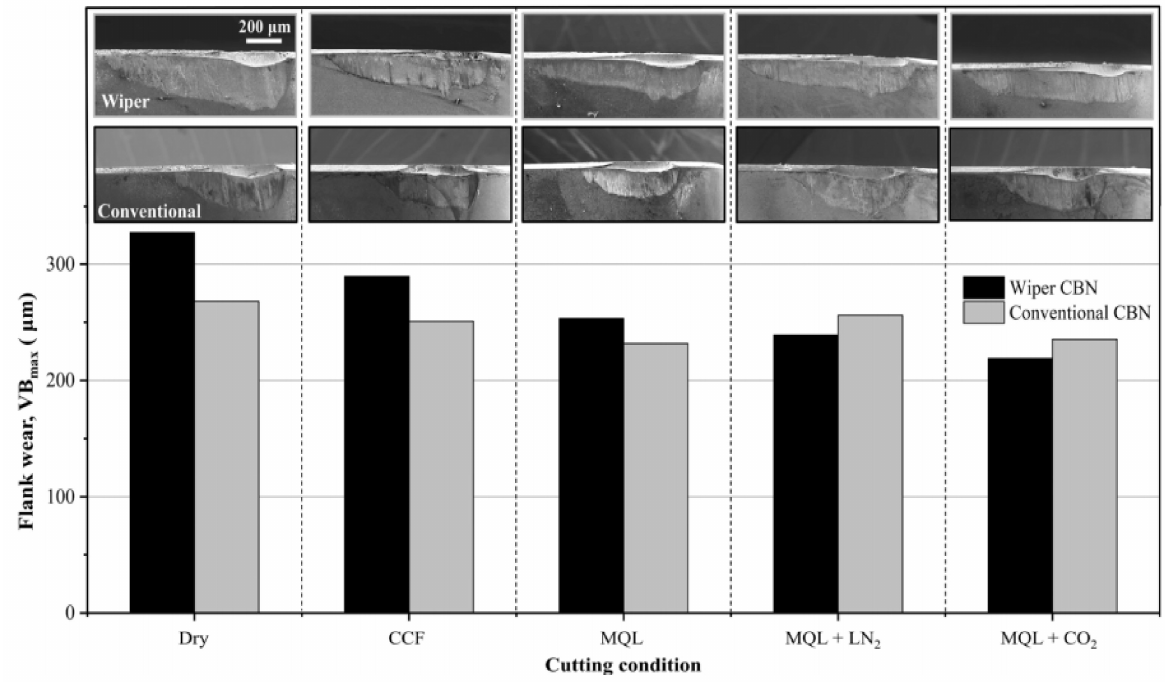
Figure 24. Wear values and SEM images of conventional and wiper CBN inserts under different cutting conditions, reprinted with permission from ref. [96]. Copyright 2020. The Society of Manufacturing Engineers. Published by Elsevier